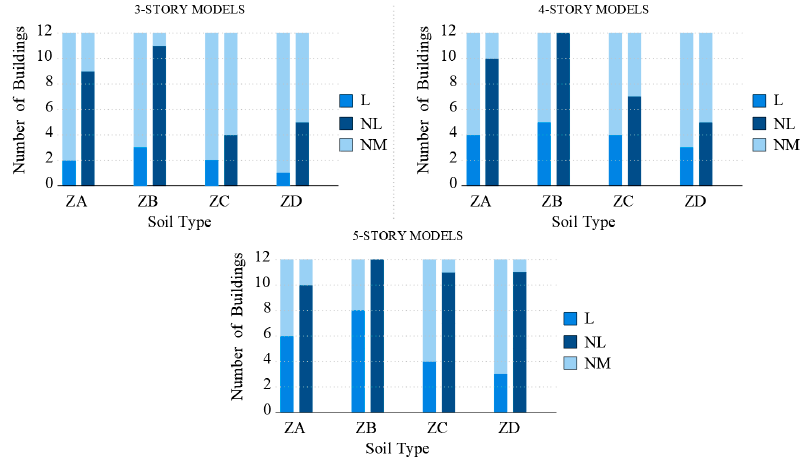
Figure 9. Distribution of buildings with sufficient performance according to the storey number/soil type parameters.